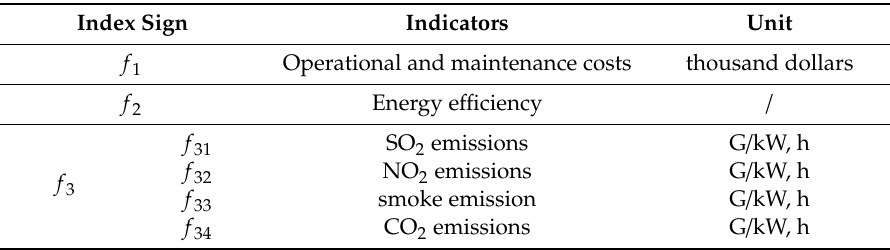
Table 1. Evaluation index of the sustainable power